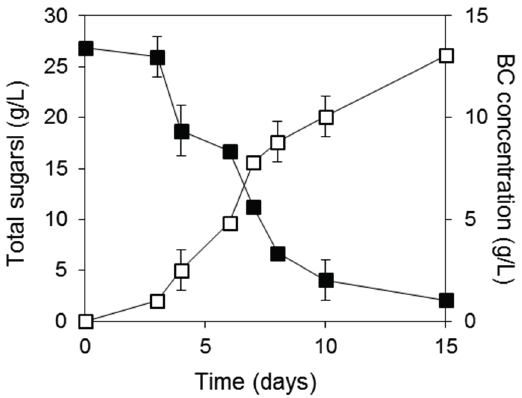
Figure 4. Total sugar consumption and BC production when FRW hydrolysates were used as fermentation media. ( ■ ), Total sugars; ( □ ), BC. Table 1. BC production using various natural resources based on literature-cited publications. Fermentation Strain Carbon Source BC (g/L) Mode Acetobacter aceti